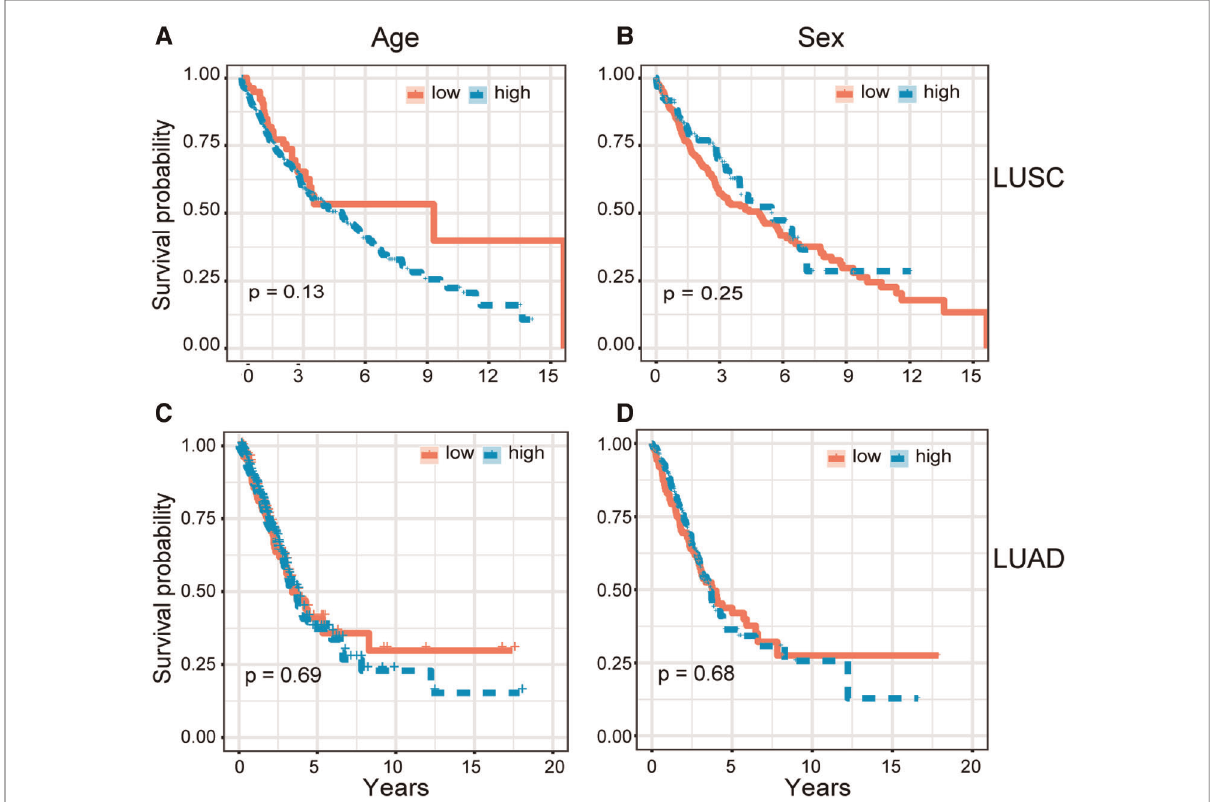
FIGURE 5 Cox univariate analysis. Relationships between clinical characteristics and patients ’ overall survival rate were shown. ( A,B ) show the relationship between patients ’ overall survival rate with age and sex for LUSC, respectively. ( C,D ) show the relationship between patients ’ overall survival rate with age and sex for LUAD, respectively.